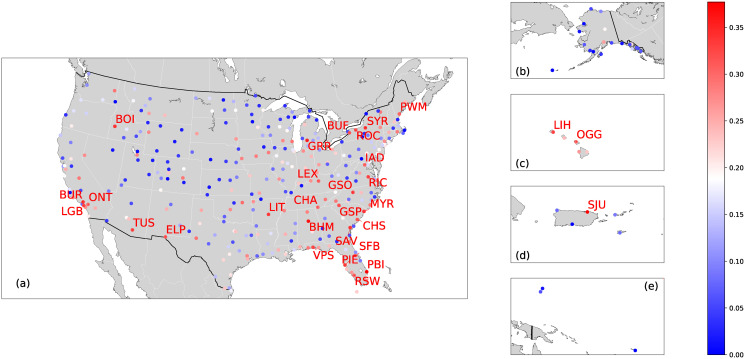
Geographic location and vulnerability of U.S. airports.The geographic location and vulnerability of an airport in U.S. mainland (a), Alaska (b), Hawaii Islands (c), Puerto Rico (d), American Samoa and Guam (e). The nodes/airports are color-coded according to their airport vulnerability ϕ. We show the names of the top 30 most vulnerable airports.